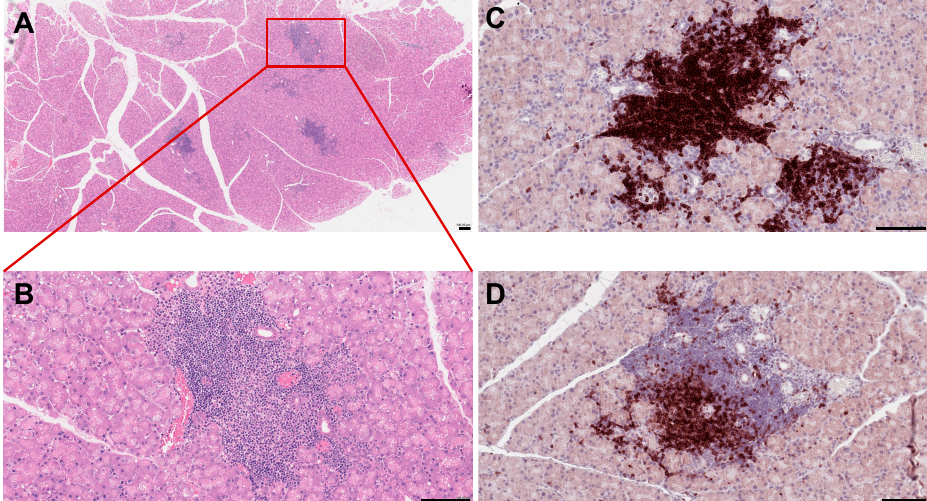
Figure 1. Histopathological features of mouse lacrimal gland at 3 months of age. ( A ) Histochemical staining of paraffin-embedded mouse lacrimal gland sections with hematoxyllin-eosin (H&E). ( B ) Higher magnification reveals severe infiltration of immune cells in the lacrimal gland. ( C ) Immunostaining of the NOD mouse lacrimal gland sections with the B220 antibody (B cell marker) ( D ) and CD3 antibody (a marker of T cells). Each scale bar is 100 μ m.